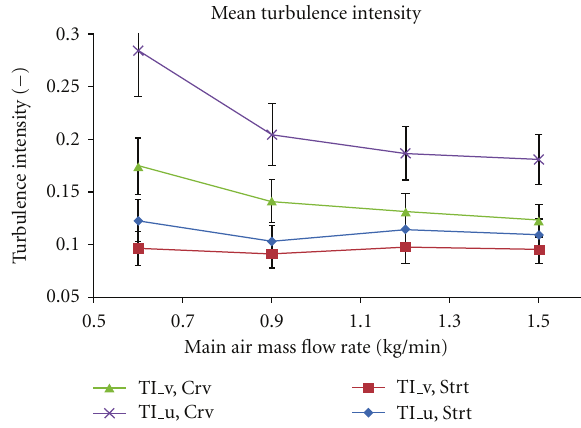
Figure 23: Planar-averaged spanwise turbulence intensity compar- ison of the straight and curved circumferential channels for an equivalence ratio = 1.0. Main and cavity airflows were 0.9 and 0.09 kg/min,